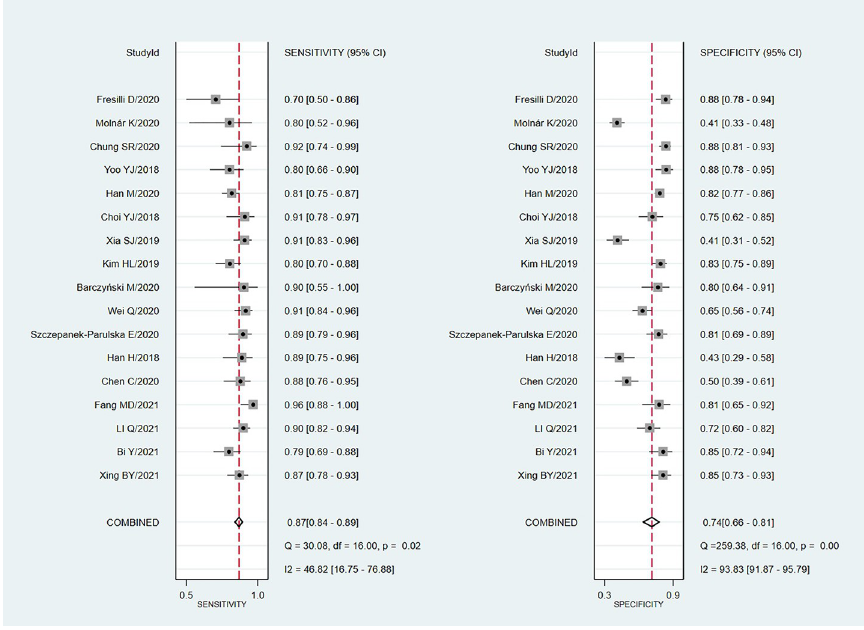
Fig 3. The Forest map results of specificity and sensitivity of S-Detect for